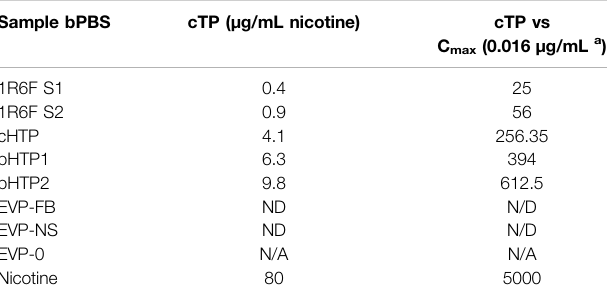
TABLE 6 | Cardiotoxicity potential fold change relative to typical nicotine concentrations following smoking a cigarette. Sample